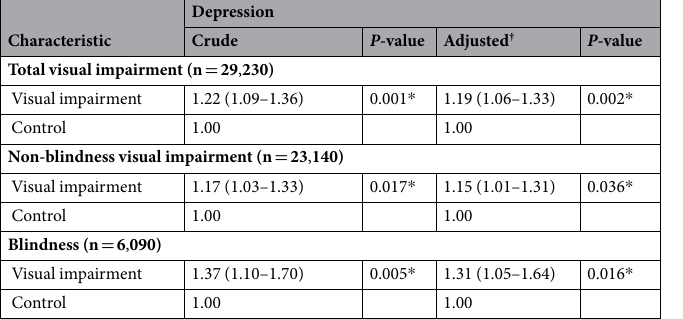
Table 2. Crude and adjusted hazard ratios (95% confidence interval) of visual impairment for depression. * Cox proportional hazard regression model; significant at P < 0.05. † Adjusted model for age, sex, income, region of residence, hypertension, diabetes, and dyslipidemia.